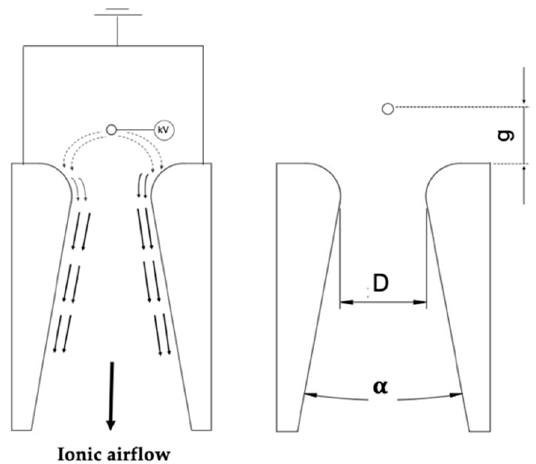
Figure 1. Scheme of the positive corona phenomenon for a wire-to-two fin configuration with characteristic geometric parameters.